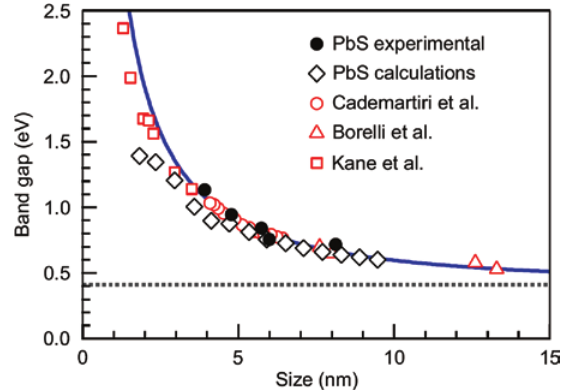
Figure 3: Effect of QD size on the bandgap of PbS QDs